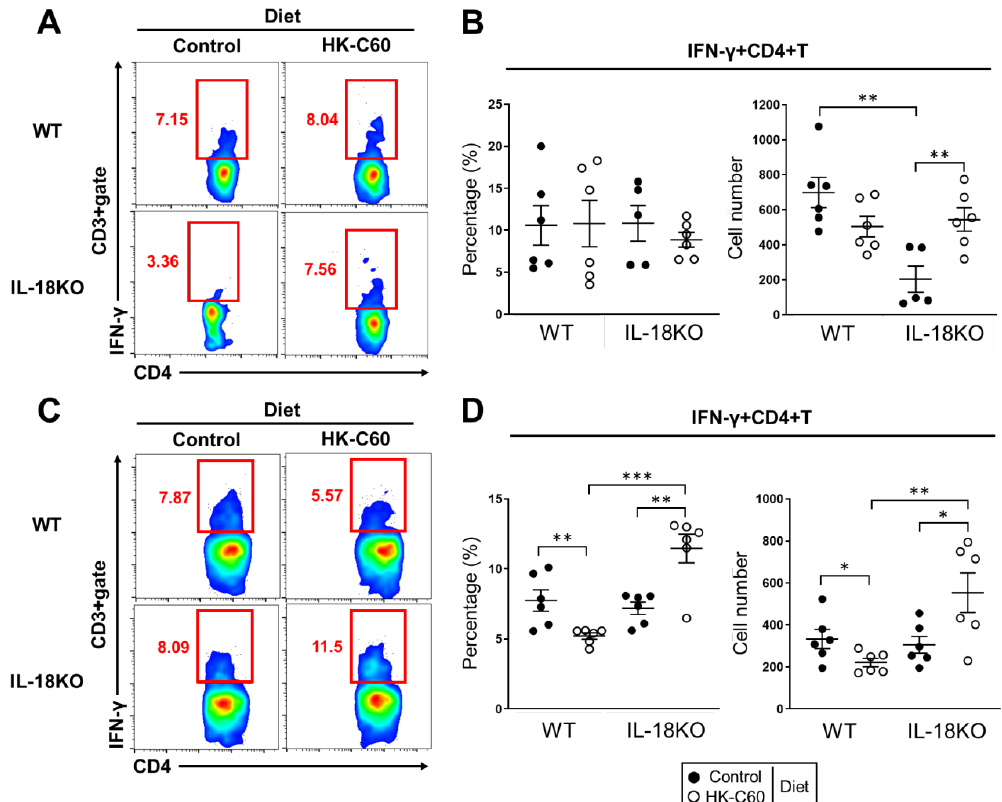
Figure 2. Th1 cell population was increased in small intestine of IL-18KO mice with HK-C60 diet. ( A – D ) Effector CD4+ T cell population in SI-LP and PPs isolated cells were analyzed by flow cytometry. The isolated cells were re-stimulated with PMA/Ionomycin combined with GolgiStop TM at 37 °C for 5 h. The representative image of IFN-γ+CD4+ T (Th1) cell population in CD45+CD3+ gate in SI-LP ( A ) and PPs ( C ). The percentage of Th1 cells in CD45+CD3+CD4+ gate in SI-LP ( B , left) and PPs ( D , left). The number of Th1 cells in CD45+CD3+gate (per 10 4 ) in SI-LP ( B , right) and PPs ( D , right). The data were shown as the representative or mean ± SEM of six samples in three independent experiments. Each dot indicates the data from one sample. A Mann–Whitney U test was used to analyze data for significant differences. Values of * p < 0.05, ** p < 0.01, and *** p < 0.001 were regarded as significant.